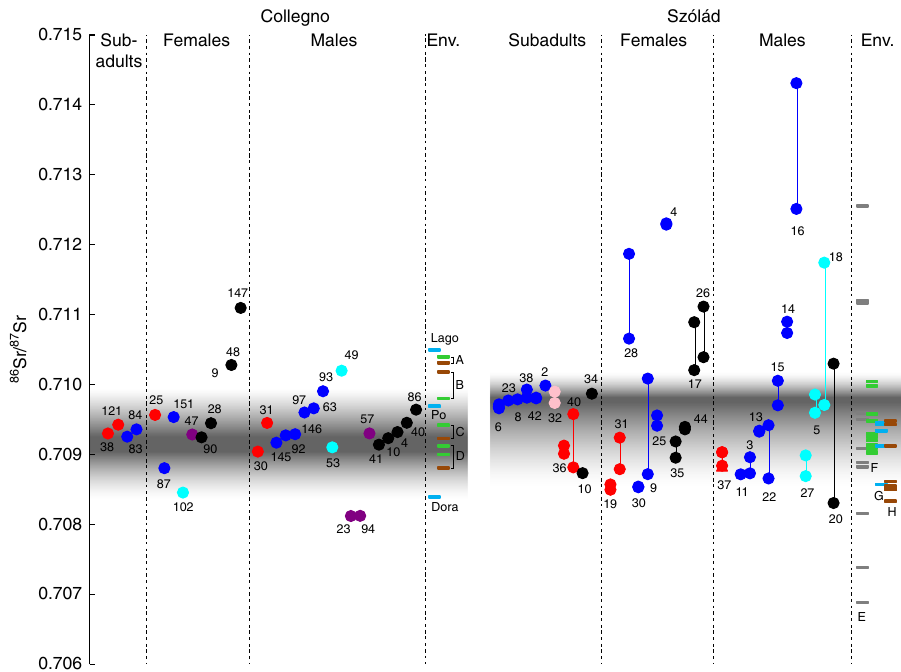
Fig. 5 Strontium isotope ratios in Szólád and Collegno. Evidence for migrants at Collegno and Szólád, as suggested by 87 Sr/ 86 Sr values of human tooth enamel and environmental reference samples. Isotopic data from Szólád were taken from the ref. 14 . The vertical lines indicate where multiple teeth were sampled from the same individual. The gray band denotes the local bioavailable strontium isotope range. Individuals falling outside of this are